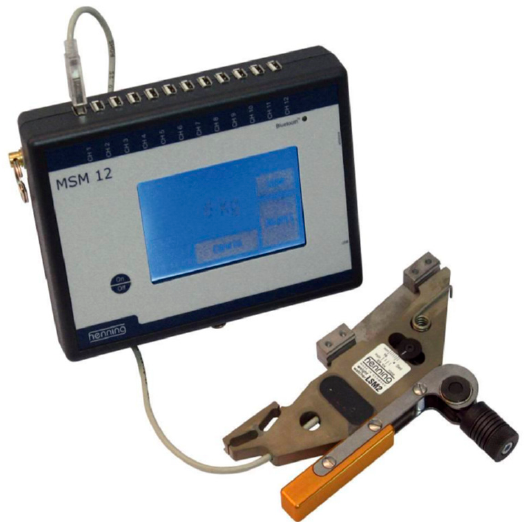
Figure 12. Schematic diagram of the performance test.